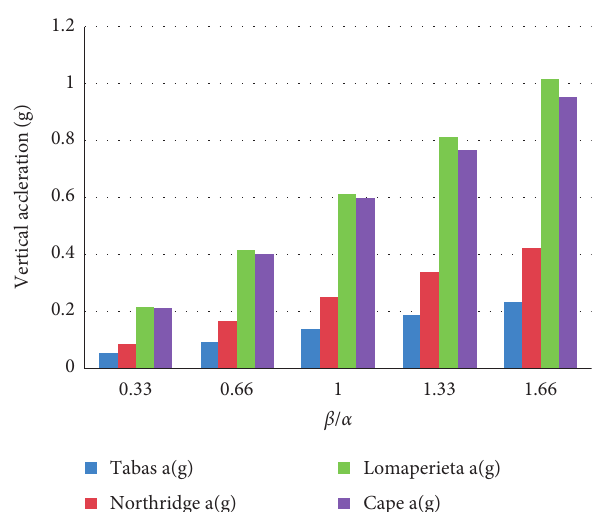
Figure 8: Maximum vertical acceleration of tunnel lining at loading 6 to 10.